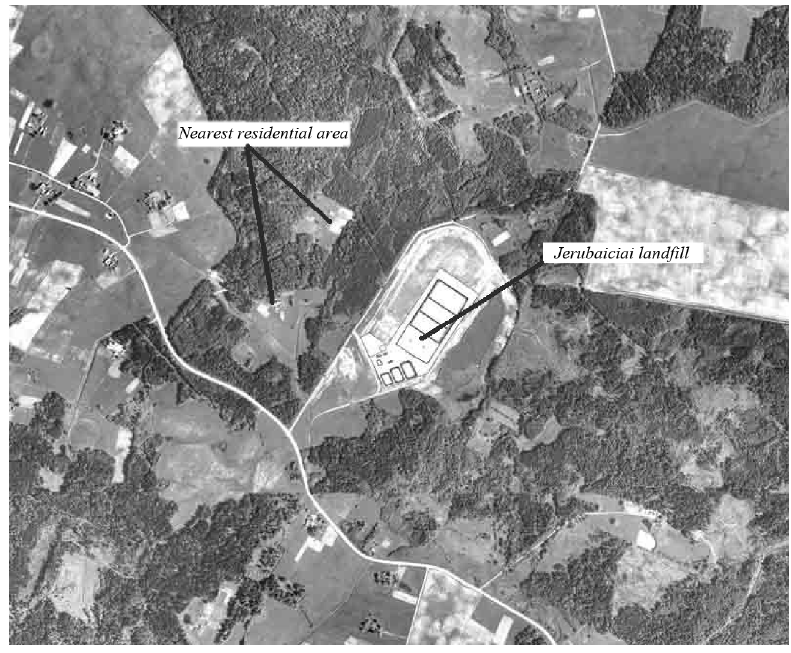
Fig. 1. Jerubaičiai